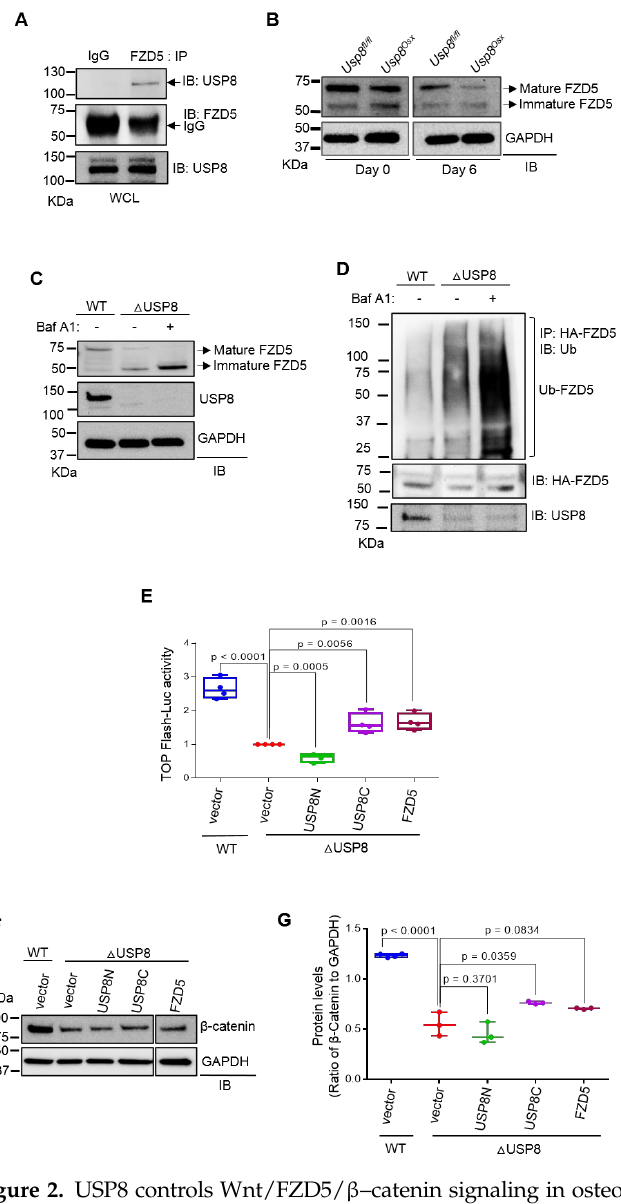
Figure 2. USP8 controls Wnt/FZD5/ β –catenin signaling in osteoblasts. ( A ) Wild–type COBs were lysed, immunoprecipitated with anti–IgG control or anti–FZD5 antibody and protein G-conjugated agarose beads and immunoblotted with the indicated antibodies. WCL; whole cell lysate. ( B ) Usp8 fl/fl and Usp8 Osx COBs ( n = 5/group) were cultured under undifferentiated or osteogenic conditions for 6 days, and lysates were immunoblotted with the indicated antibodies. GAPDH was used as a loading control. ( C ) Usp8 fl/fl COBs were transduced with lentivirus expressing vector (WT) or CRE recombinase ( ∆ USP8). Two days after puromycin–selection, cells were treated with vehicle or Bafilomycin A1 (Baf A1, 10 nM) overnight and immunoblotted with indicated antibodies. ( D ) HA–FZD5–expressing WT and ∆ USP8 COBs were treated with 10nM of Baf A1 overnight, immunoprecipitated with anti–HA conjugated agarose, and immunoblotted with anti–ubiquitin antibody. ( E ) WT or ∆ USP8 COBs were transfected with a TopFlash luciferase reporter gene along with vector, USP8C, USP8N, or FZD5. Cells were cultured under osteogenic condition for 3 days, and β –catenin activity was assessed by measuring luciferase activity. ( F , G ) WT or ∆ USP8 COBs expressing vector, USP8C, USP8N, or FZD5 were immunoblotted with indicated antibodies. Protein levels of β –catenin were displayed by the ratio of β –catenin to GAPDH loading control ( n = 3). Data are shown as a box-and-whisker plot (with median and interquartile ranges) from min to max, with all data points shown. Statistical analysis was performed using an unpaired Student’s t–test within